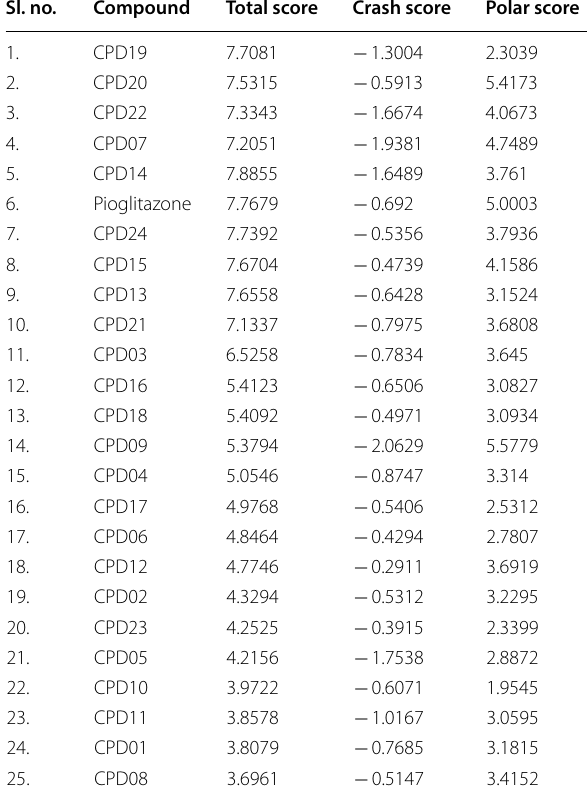
Crash score: revealing the inappropriate penetration into the binding site Polar score: reports the polar region of the ligands